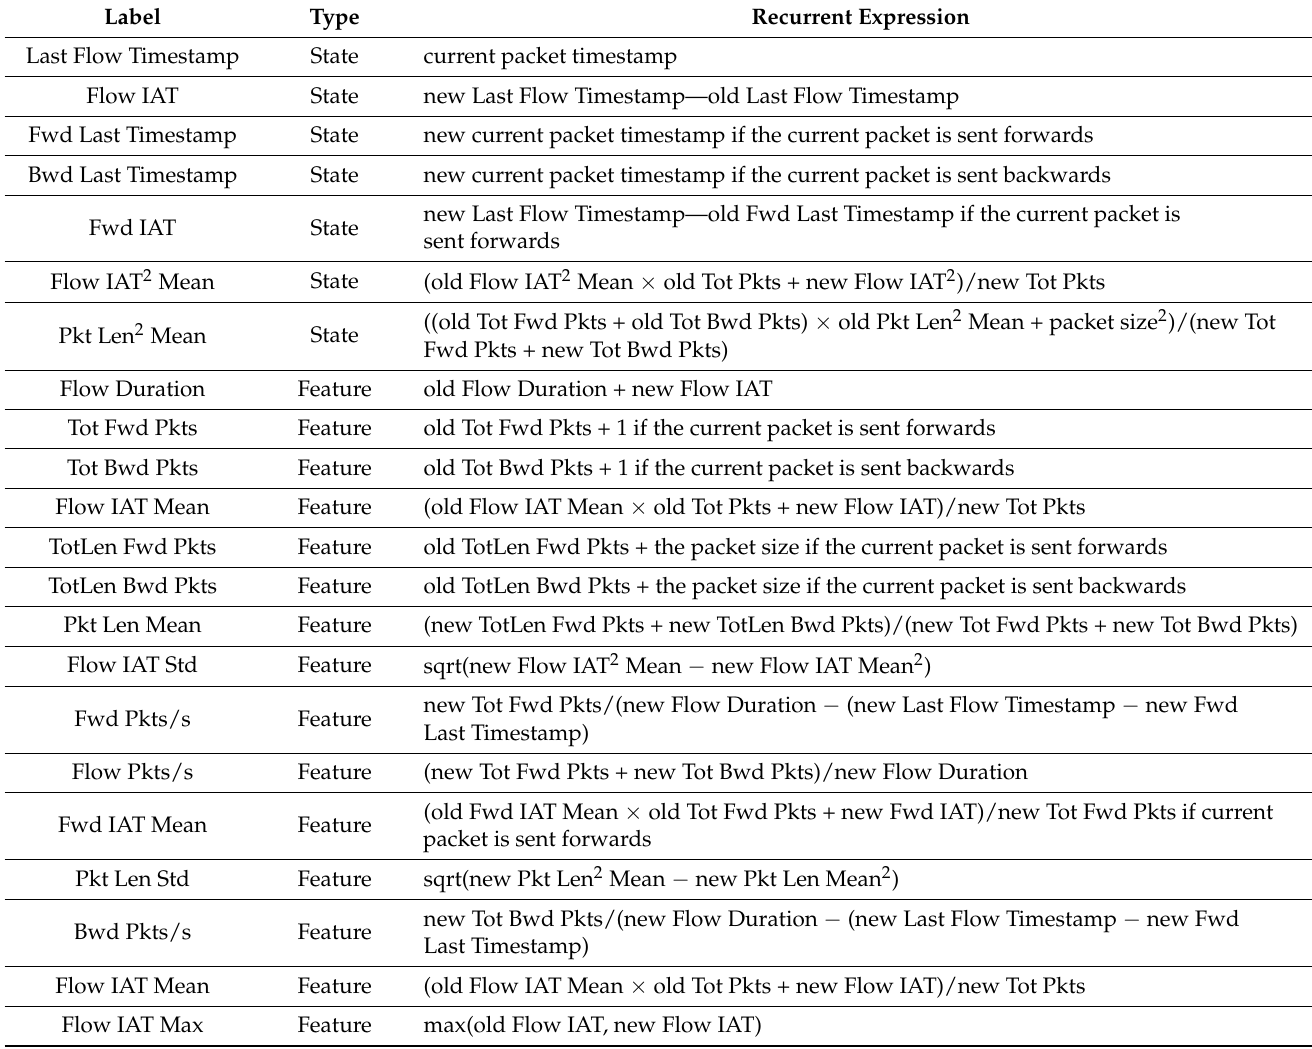
Table 4. Recurrently creating selected features without storing any packet data. Fifteen features are created recursively using seven states in addition to fifteen features. For example, for the Flow Duration feature, ‘old Flow Duration + new Flow IAT’ implies that a new Flow Duration value can be obtained by adding the updated Flow IAT value to the previous Flow Duration, when a new packet belonging to the current session is